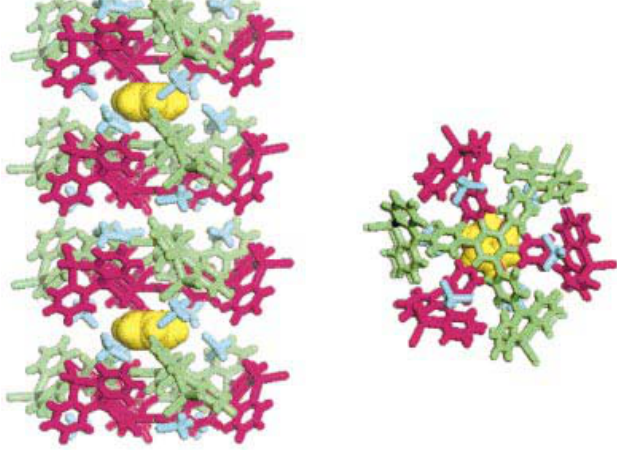
Figure 15. Stick/space-filling diagrams showing the sandwiched arrangement of benzene ) (TPDPB)] in crystal A, viewed along c -axis (left) and viewed down the c -axis and [(ZnCl 2 3 Cl : light blue, stick. The interlocked pairs of (right). Benzene: yellow, space filling; CH 2 2 molecules of [(ZnCl ) (TPDPB)] are shown as red and green, respectively. Reproduced 2 3 with permission from